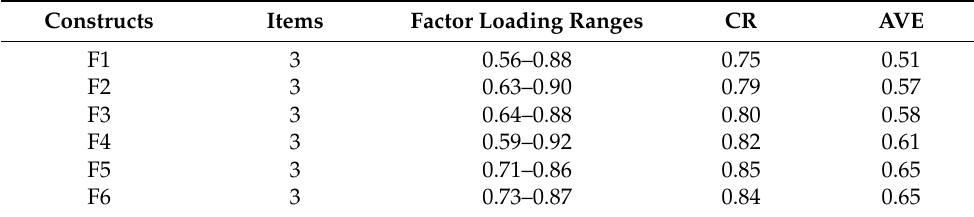
Table 1. Convergent validity of PASS.